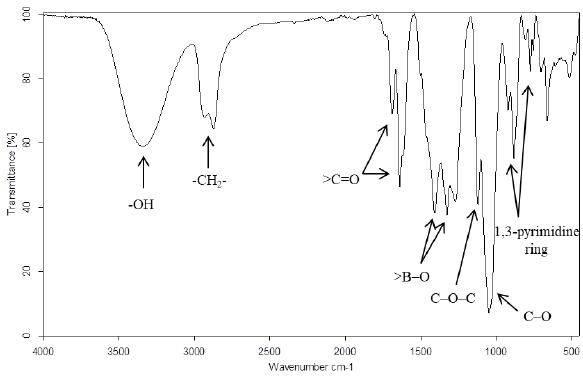
Figure 1: IR spectrum of the oligoetherol obtained from 1 mol of 6-aminouracil (AU), 16 (4+12) moles of ethylene carbonate (EC) and 3 moles of boric acid (BA). Table 1: Elemental analysis of oligoetherols. Product of reaction